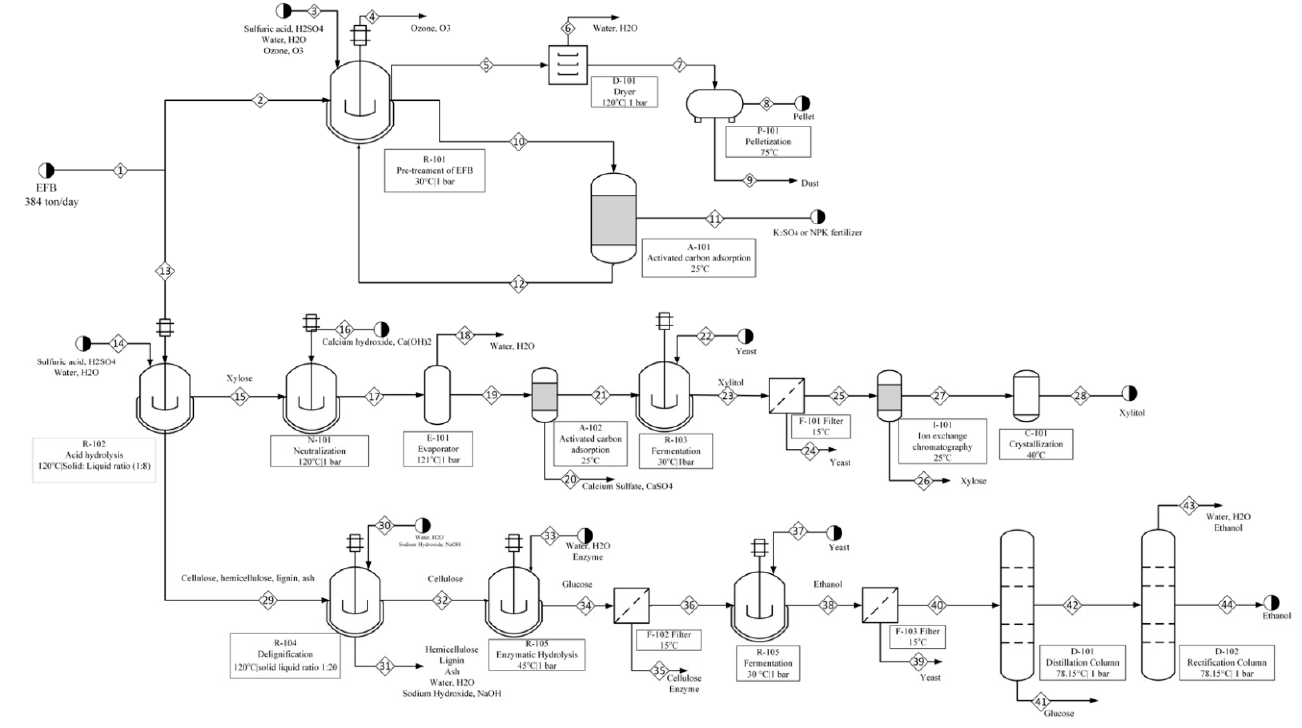
Figure 2. Process flow diagram of the proposed integrated bio-refinery. Table 1. Overall Mass Balance Summaries at a 30% EFB Splitting Ratio to Pellet